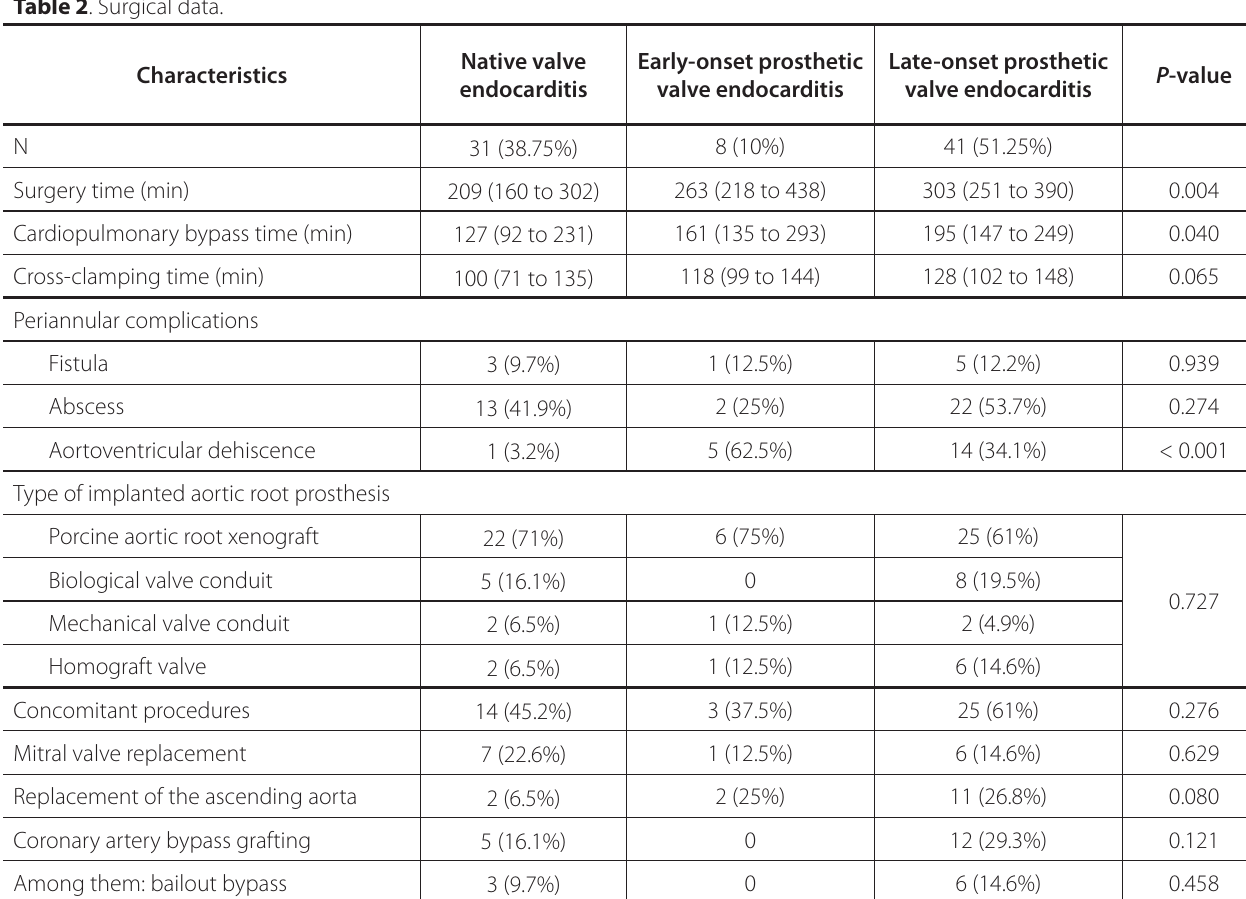
Table 2 . Surgical